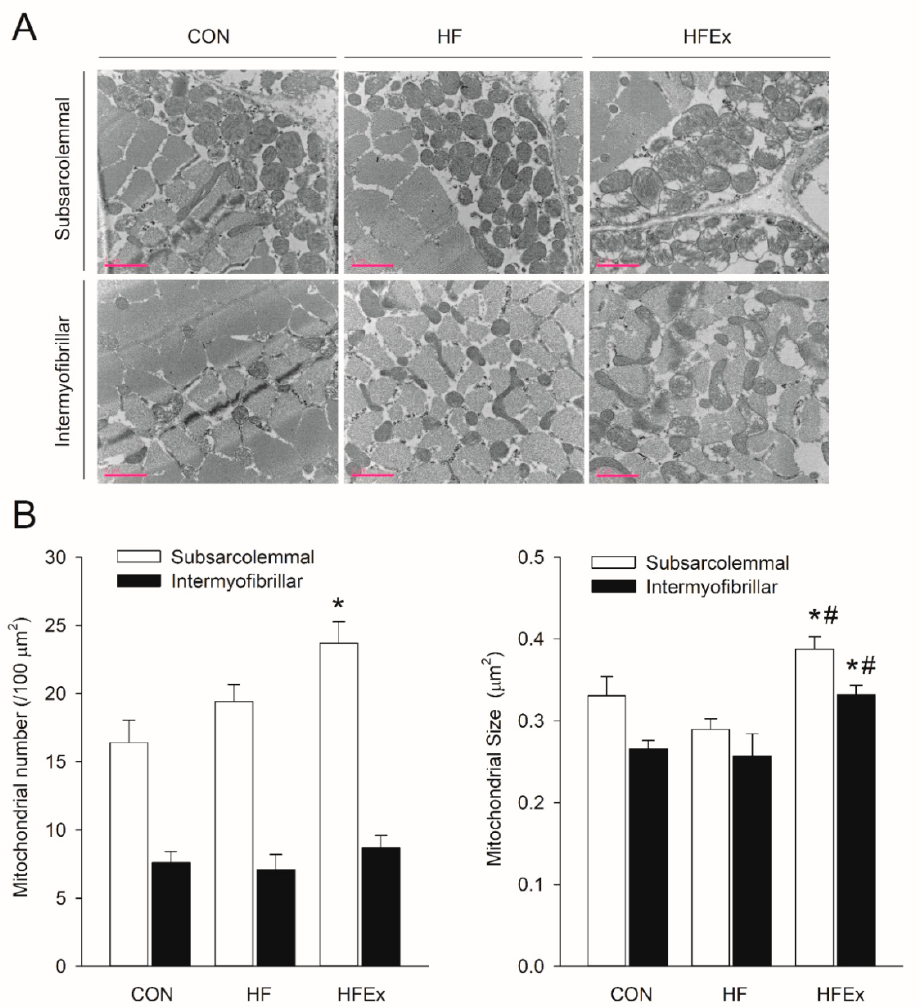
Figure 5. Effects of HFD or HFD and exercise on mitochondrial number and size in the EDL muscle. ( A ) Representative transmission electron micrograph (TEM) images of the rat EDL muscle. Scale bar = 2 µ m. ( B ) Summary data of mitochondrial number per area and the size of individual mitochondria. Data are presented as means ± SEM. Data was analyzed by a one-way ANOVA. * p < 0.05 vs. CON, # p < 0.05 vs. HF. CON, control; HF, HFD intake; HFEx, high-fat diet with low-intensity endurance exercise; EDL, extensor digitorum longus.